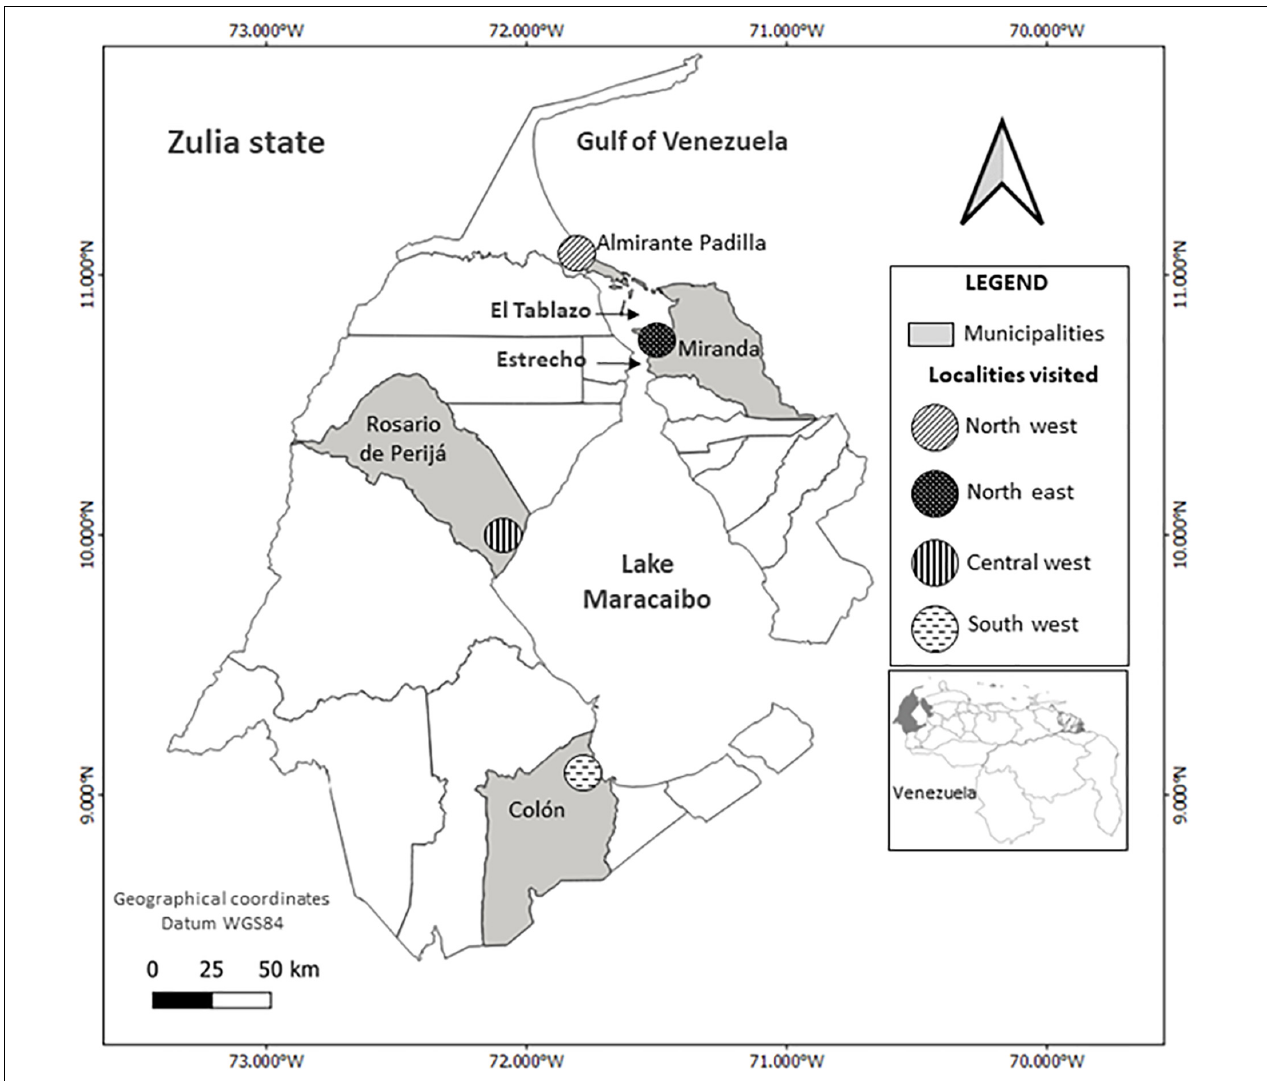
FIGURE 1 | Zulia state with the location of the fishing communities visited San Carlos, Zapara and Toas islands (northwest), Los Puertos de Altagracia (northeast), Barranquitas (central west), Puerto La Concha, and Ologá